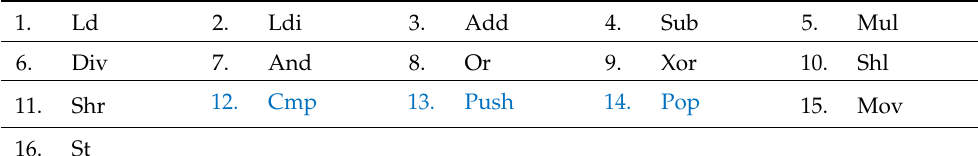
Table 5. CPU0 instruction table and the execution sequence patterns.